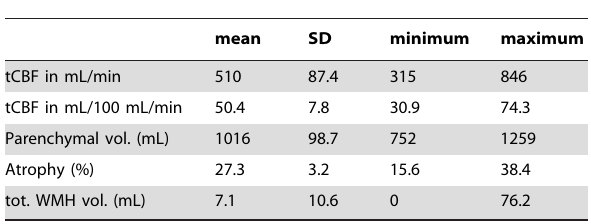
Table 2. MR characteristics.